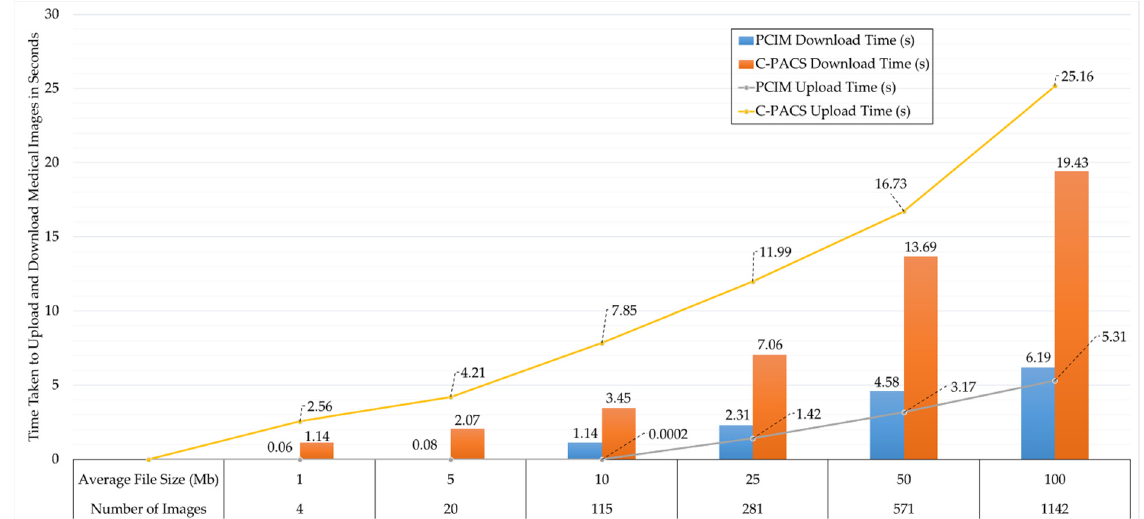
Figure 10. Showing the Average Time Taken to Upload and Download the Medical Images of Various Sizes by the Proposed and Conventional PACS Storage in Seconds (s). The Bar Graph Represents the Download Time and the Line Graph Represents the Upload Time of the Two Systems. The Dashed Lines Represent the Numerical Data Labels of the Line Graph.